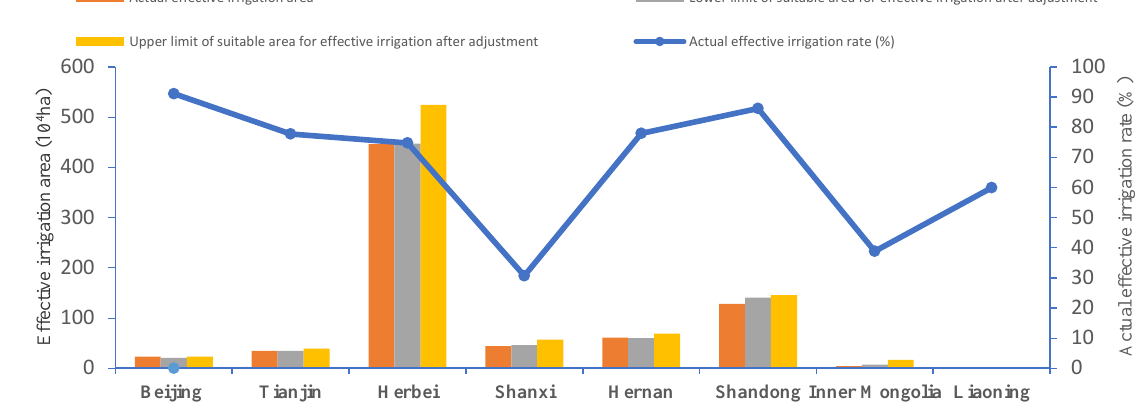
Figure 4. Actual effective irrigation area, rate, and suitable effective irrigation area after adjustment. Figure 4. Actual e ff ective irrigation area, rate, and suitable e ff ective irrigation area after adjustment.